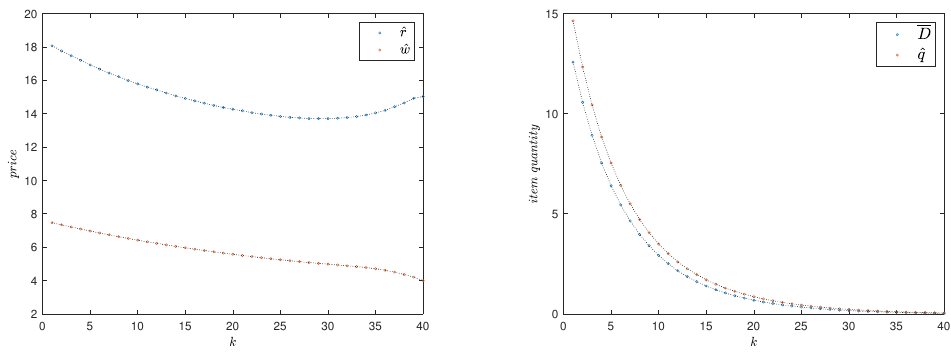
Figure 2. Pricing and supply quantities at equilibrium states in Example